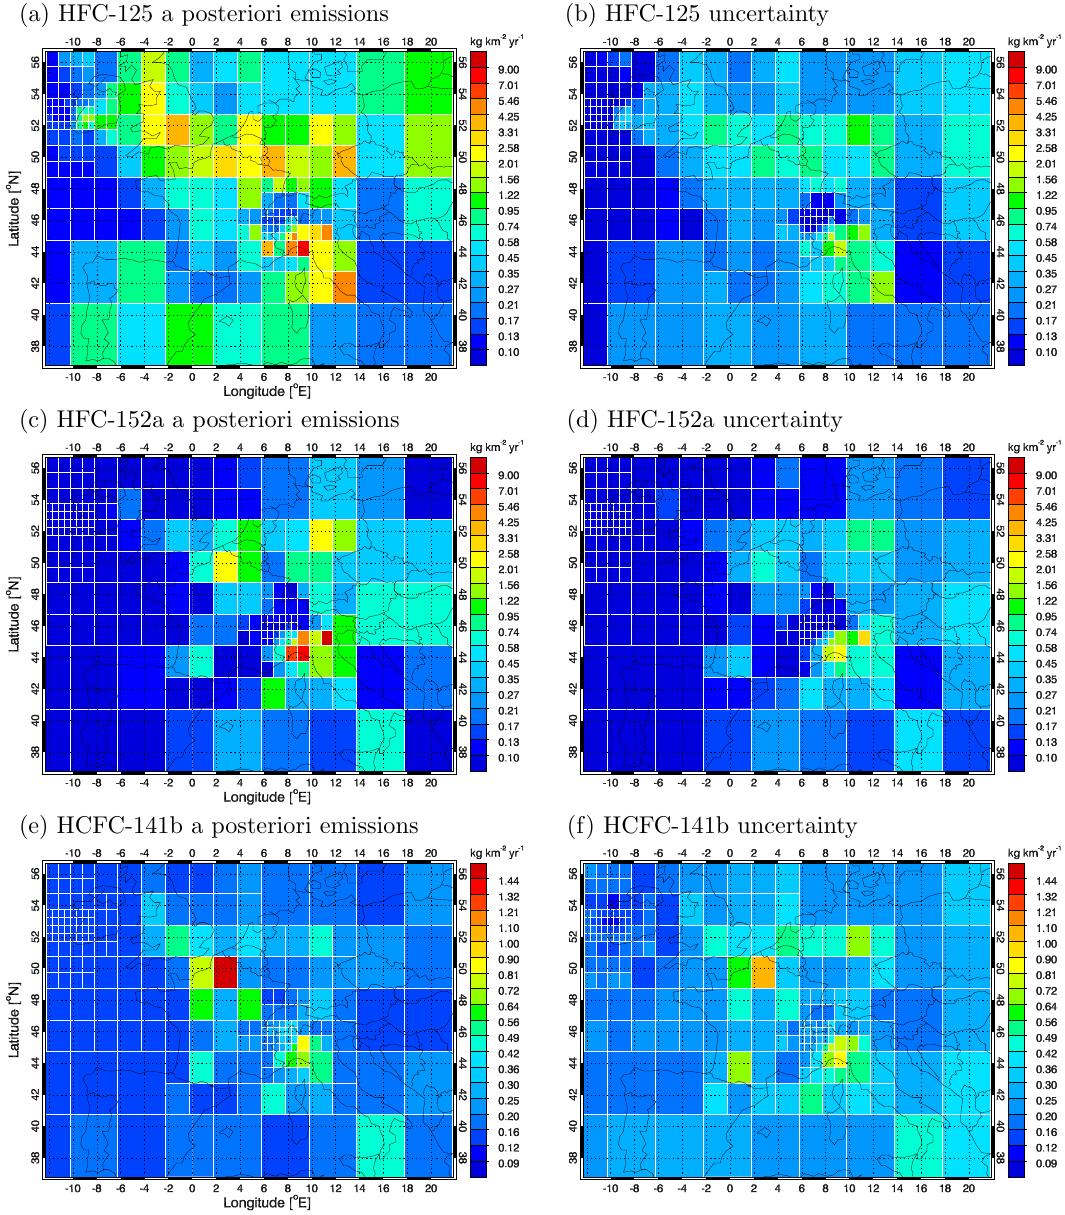
Fig. 10. Distribution of annual mean emissions (left) and their uncertainties (right) of HFC-125, HFC-152a and HCFC-141 in Europe in 2009.